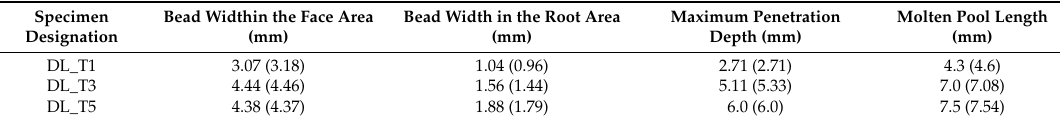
Figure 14. View ( a ) of the method of loading the mesh elements and placement of the conical model of the heat source, comparing (b) the shape of the bead on the cross-section, ( c ) the shape and size of the weld pool, and ( d ) the longitudinal section of DL_T5 test bead with the results of numerical analyses (Tables 3 and 4). Table 4. Comparison of geometric dimensions of selected beads on the bead-on-plate laser welding values obtained from numerical analysis (values in brackets) (Table 3, Figures 12–14).